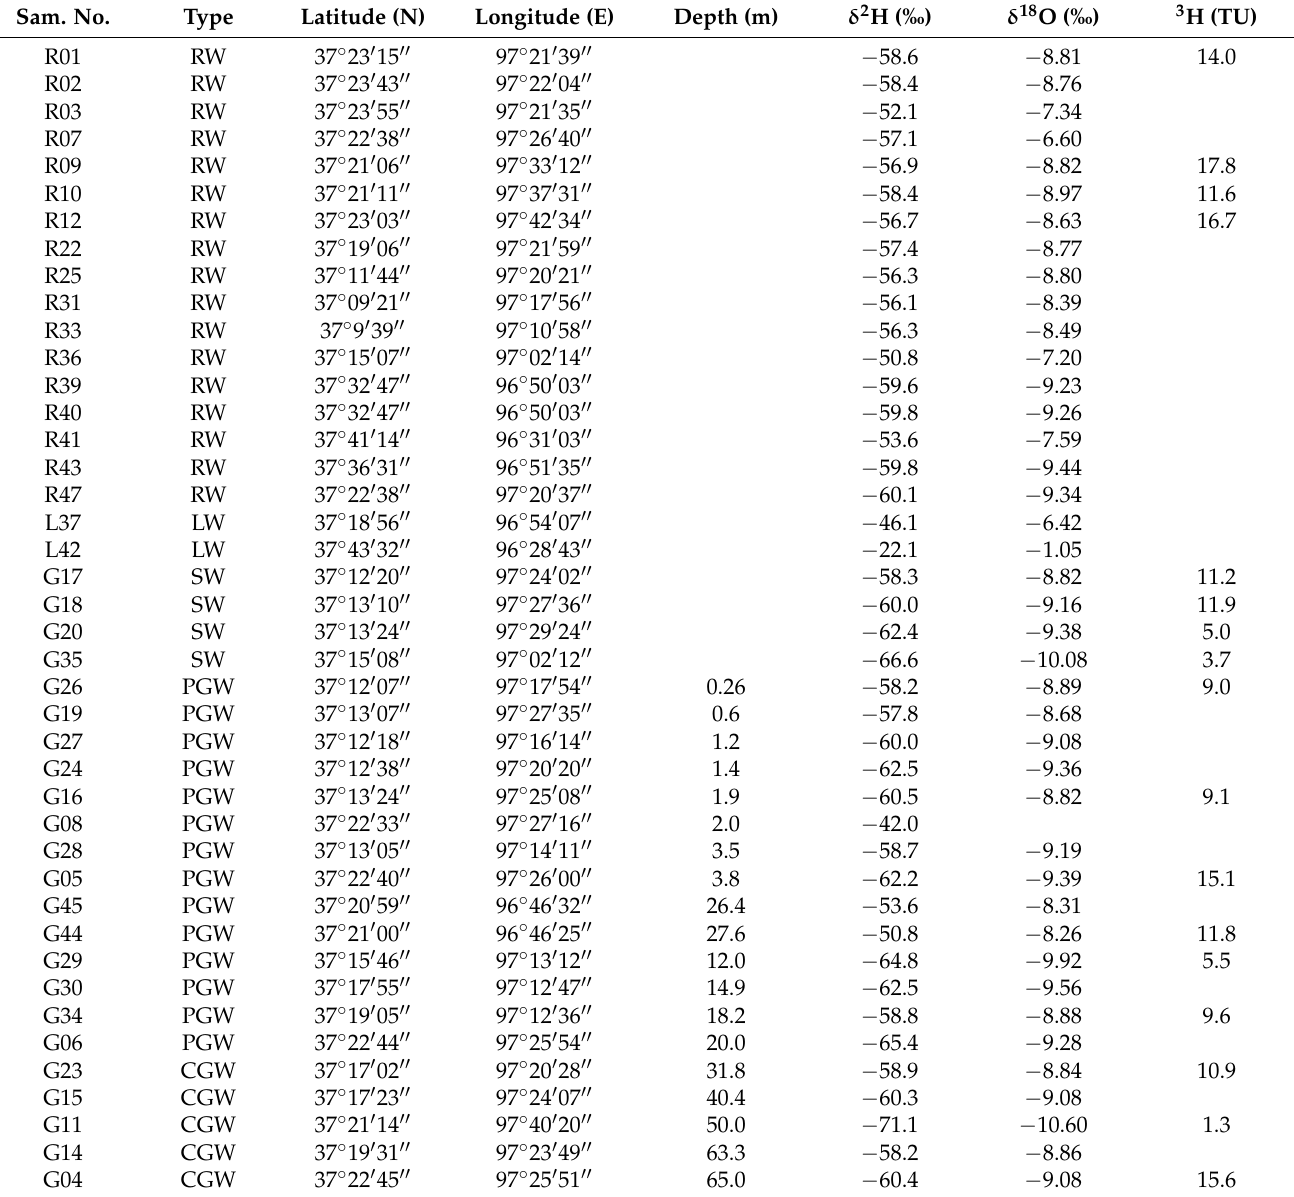
Table 2. Isotope measurement results ( 2 H, 18 O, and tritium) for different water samples in the study area. Sam.